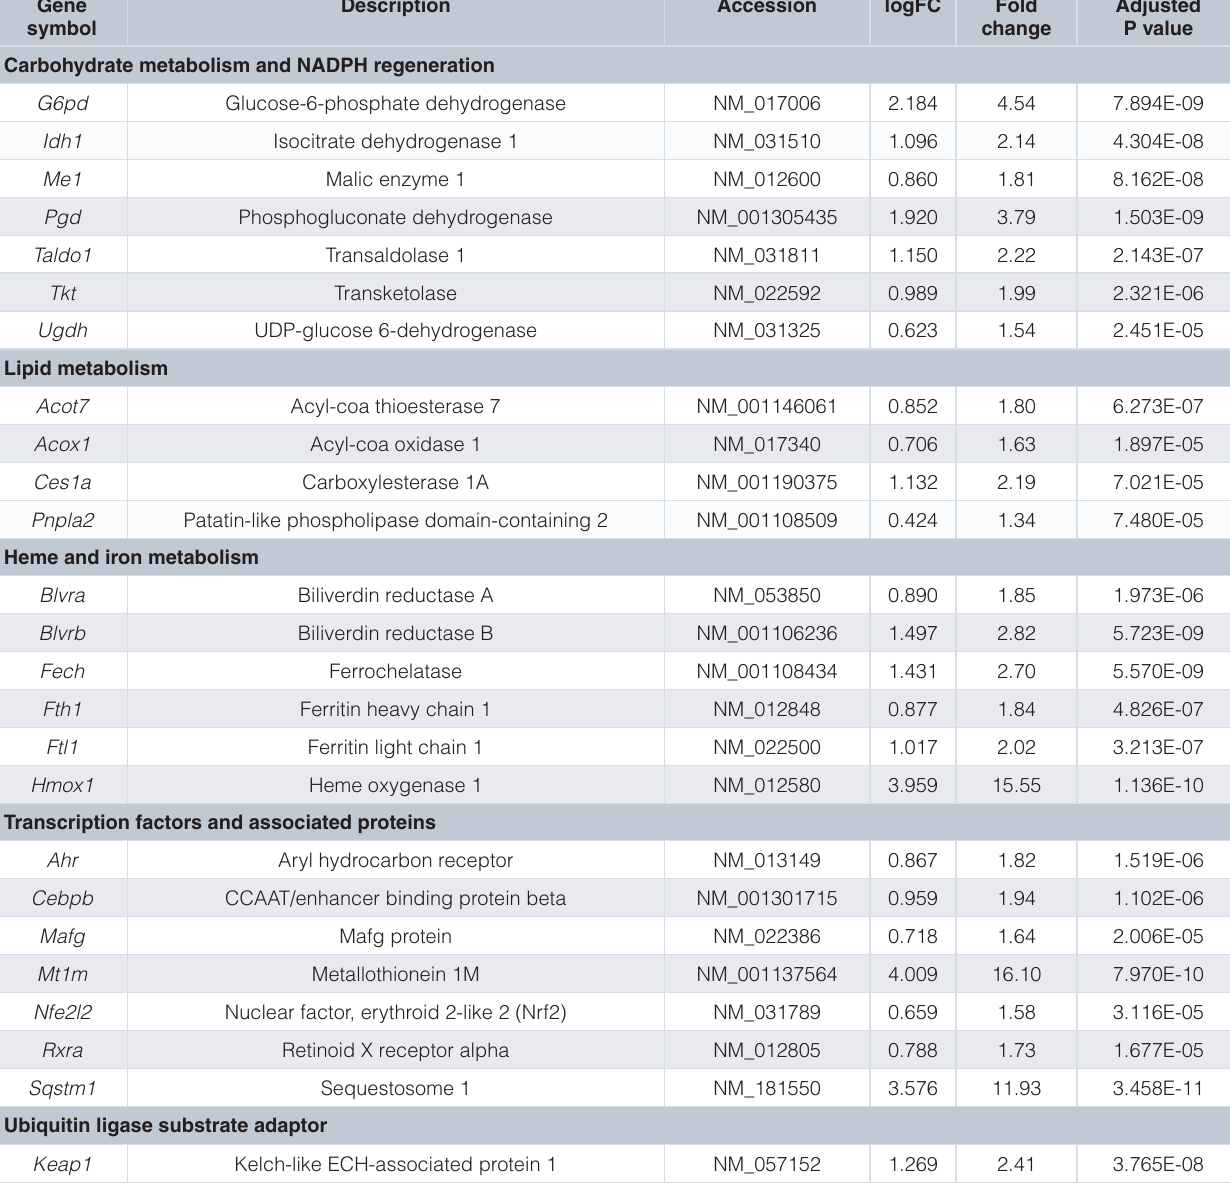
(Table 1). Prior to our study, the effects of strigolactones treatment on the mammalian cell transcriptome have only been investigated in human osteosarcoma cells, where strigolactone analogs mainly upregulated the heat shock stress proteins and downregulated the cell cycle 5 . Activation of Nrf2 signaling is known to have beneficial effects in cancer, metabolic syndrome, obesity, nephropathy, retinopathy, neuropathy, and β -cell protection. Nrf2 regulates the transcription of genes involved in antioxidant,